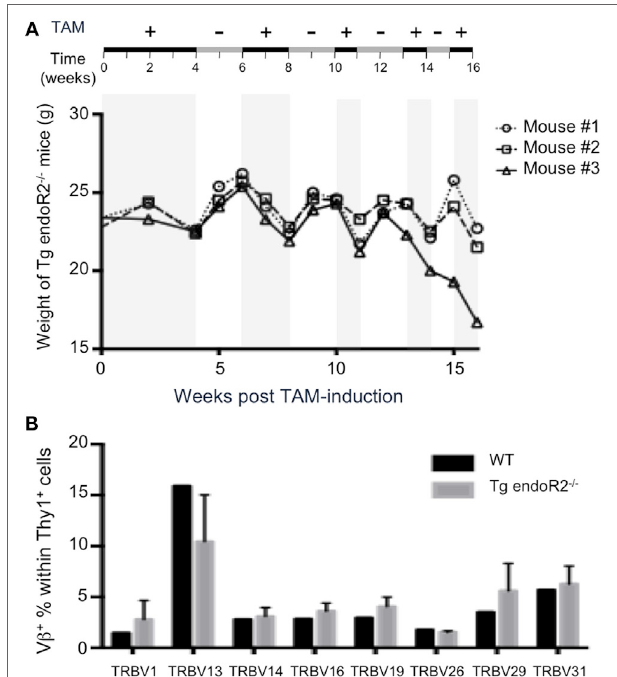
FigUre 6 | Alternated on and off 4-hydroxytamoxifen (TAM) administration reduces toxicity and promotes completion of the Vbeta repertoire. (a) Tg endoR2 − / − mice were treated for 16 weeks with alternate periods on ( + ) and off ( − ) TAM food (upper scheme), and body weight kinetics established along the treatments. (B) By week 16 of the alternate treatment in (a) , thymocytes were analyzed by FACS, and wild-type (WT) thymocytes served as control. Shown is the proportion of Thy1 + thymocytes expressing each of the 8V β